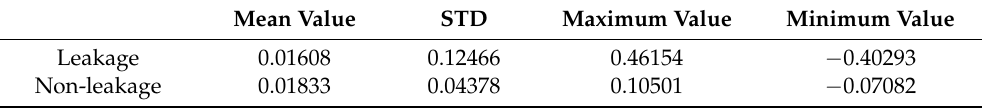
Figure 8. Leak and non - leak acoustic signal analysis: ( a ) time - domain measurement results of no leak and leak, ( b ) normalized frequency domain measurement results of no leak and leak. Table 2. The statistical values of the leakage and non - leakage signals.